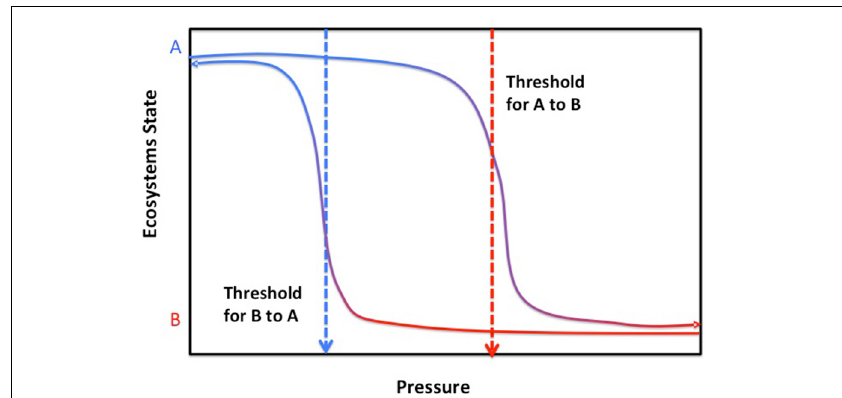
FIGURE 4 | The relationship between pressure and the trajectories of ecosystem states presenting alternative stable states (A,B), indicating the trajectories of change in ecosystem state when pressures increase, with the corresponding thresholds for abrupt change from state A to B with increasing pressure (red dotted arrow), and that for ecosystem state when pressures are relaxed, with the corresponding thresholds for abrupt change from state B to A with decreasing pressure (blue dotted arrow). Examples of thresholds delineating shifts in alternative states in response to pressures in the marine environment are provided in Table 2